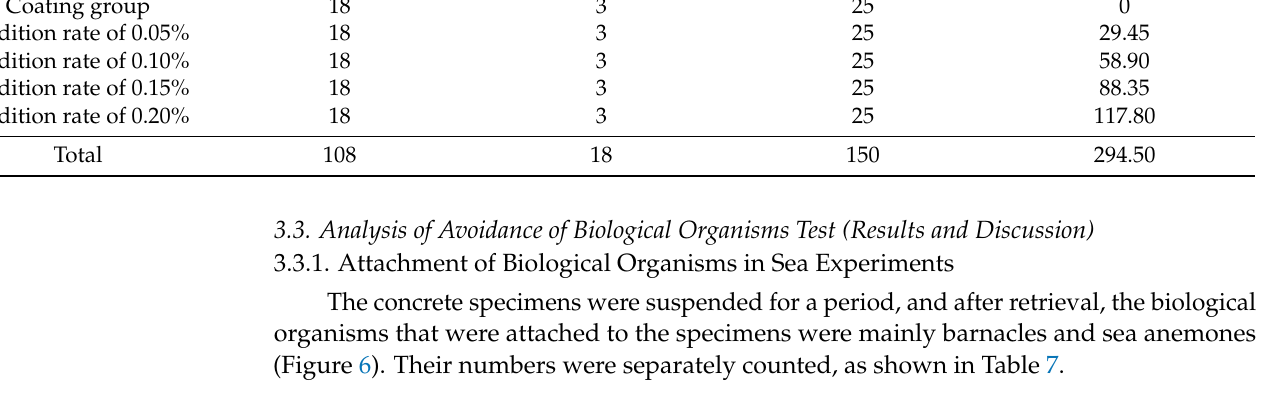
Table 7. Statistics on the number of biological organisms attached to concrete test blocks for sea